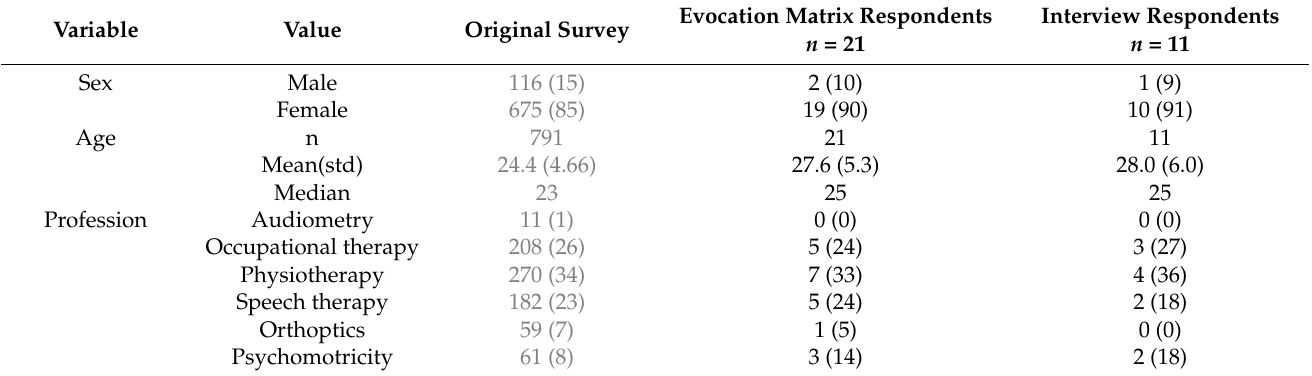
Table 2. Profile of